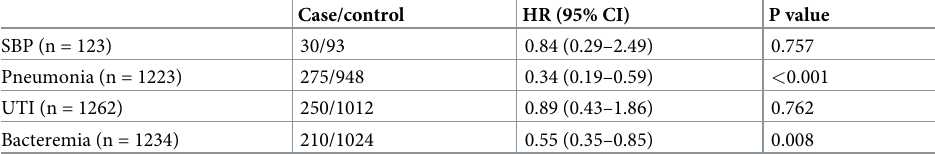
Table 4. Adjusted hazard ratios of risk factor of statins for 30-day mortalities of cirrhotic patients with different bacterial infections.